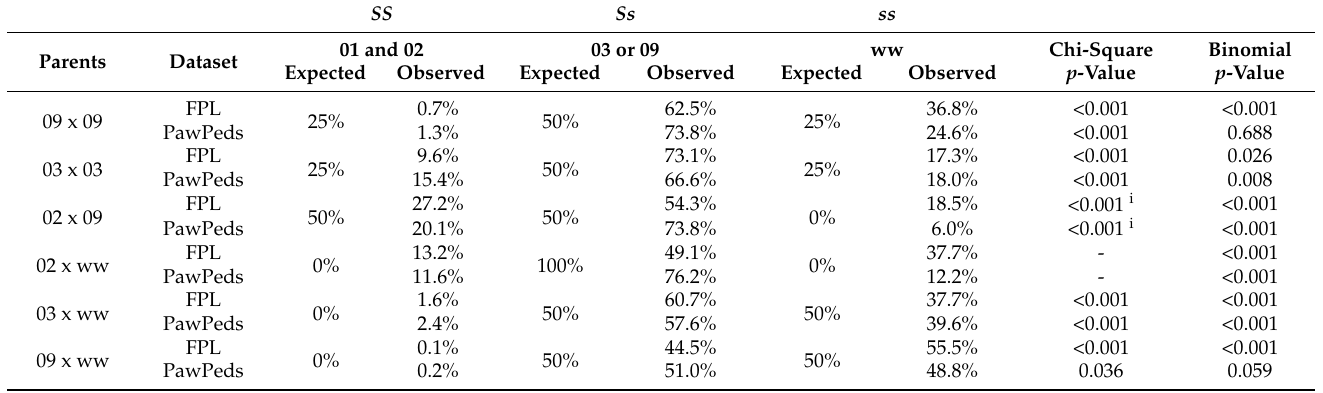
Table 3. Statistical tests for independence between given and theoretical distributions according to Mendel’s